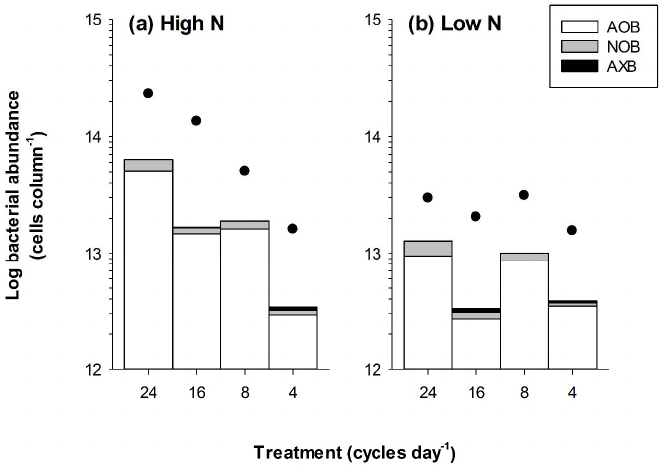
Figure 3. Integrated bacterial abundance for the ( a ) High-N and ( b ) Low-N reactors for each cycling frequency. Functional groups are presented in the bar graph as ammonium oxidizing bacteria (AOB), nitrite oxidizing bacteria (NOB), and anammox bacteria (AXB); total bacteria abundance is shown with the black circles.